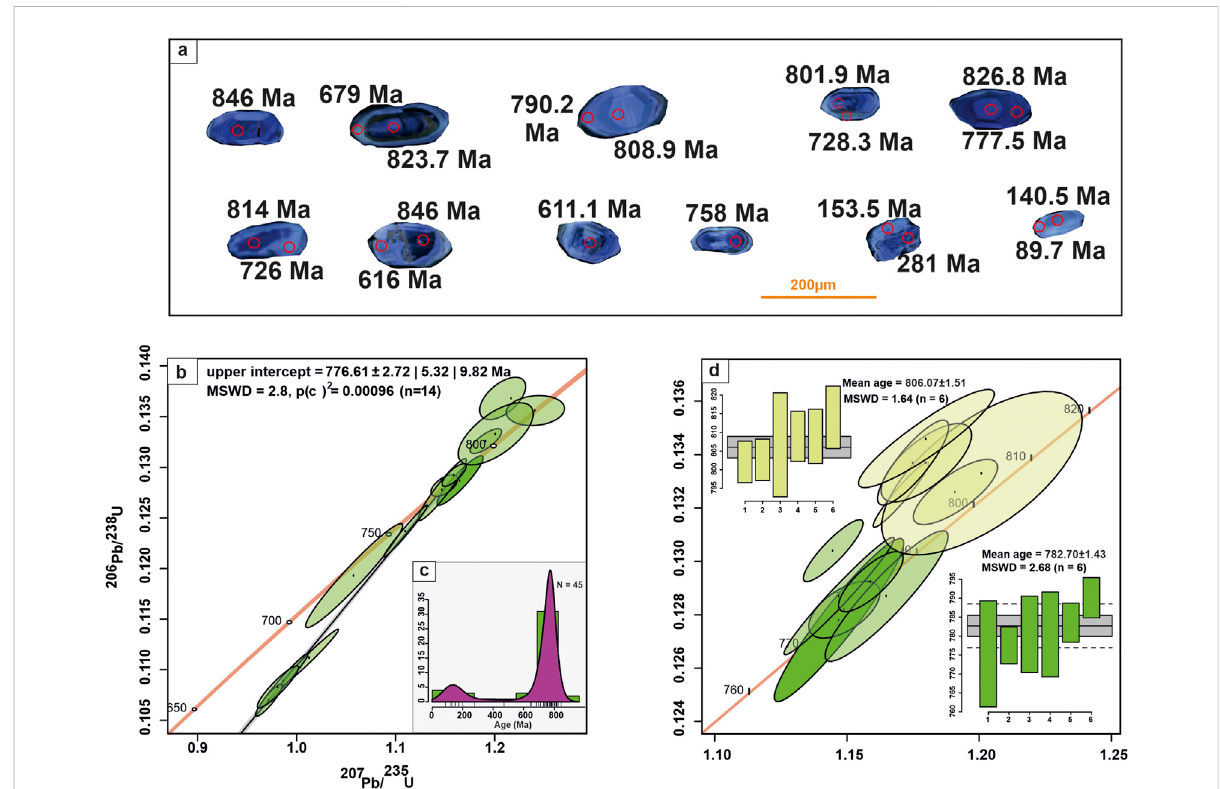
Figure S1; Streckeisen 1976; Le Maitre 2002), the granite gneiss (SM 4 M) corresponds to